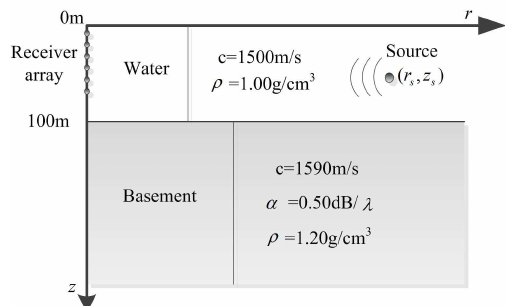
Figure 1. The typical calibration case (CALIB) environmental model in the workshop. It is a two-layer environmental model with geoacoustic parameters of water and